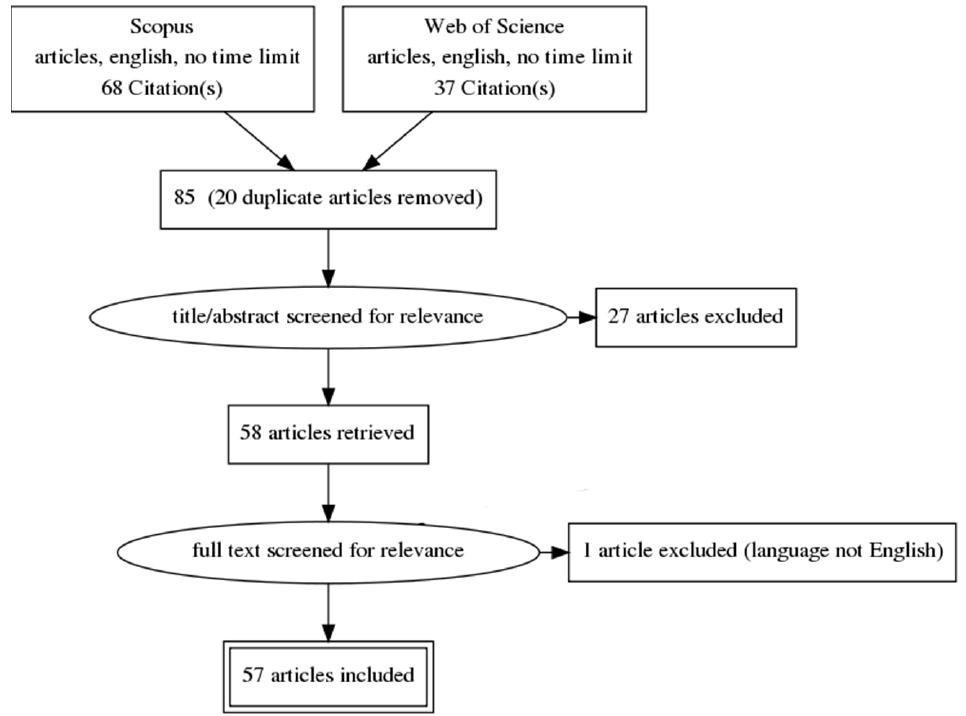
Figure 1. Systematic review flow diagram. Generated by PRISMA Flow Diagram Generator. Available online: http://prisma.thetacollaborative.ca/ (accessed on 20 March 2021).